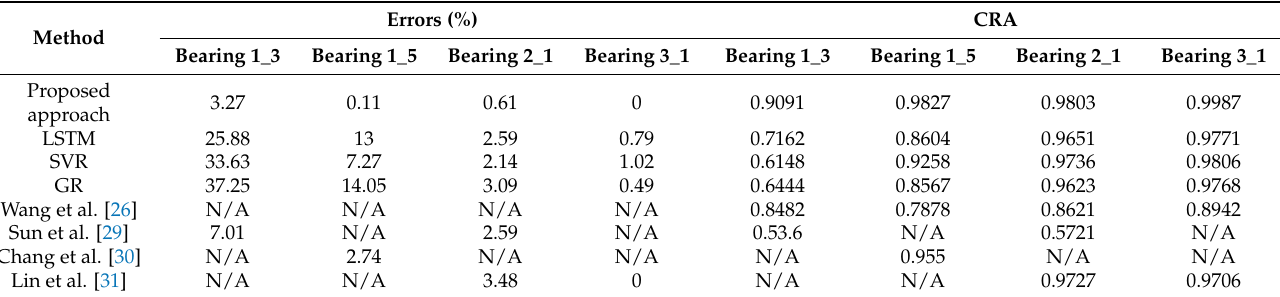
Table 1. Performance evaluation for all approaches using two